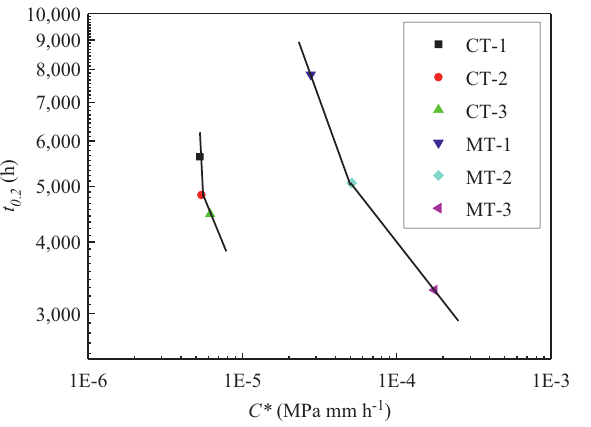
Figure 7: The relations between t 0.2 and C* for C(T) and M(T) specimens at the same initial stress intensity factor K in = 7 MPa.